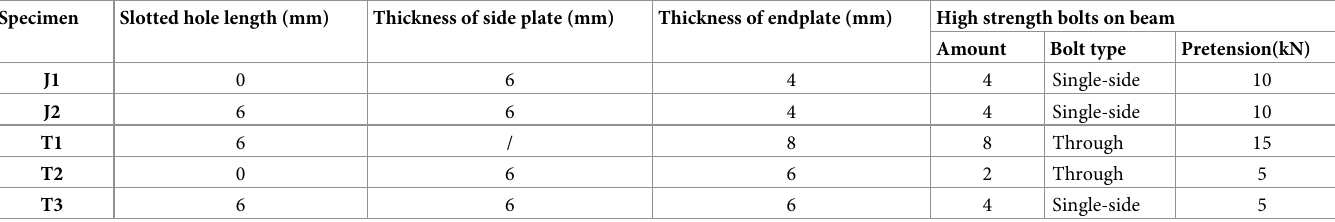
Table 1. Specimen components. Specimen Slotted hole length (mm)